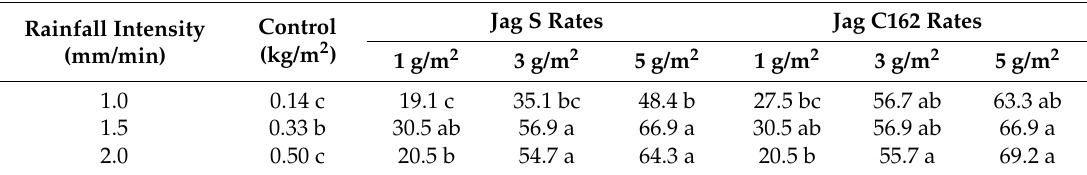
Table 4. Reductions of cumulative erosion modulus under different rainfall intensities (Jag S and Jag